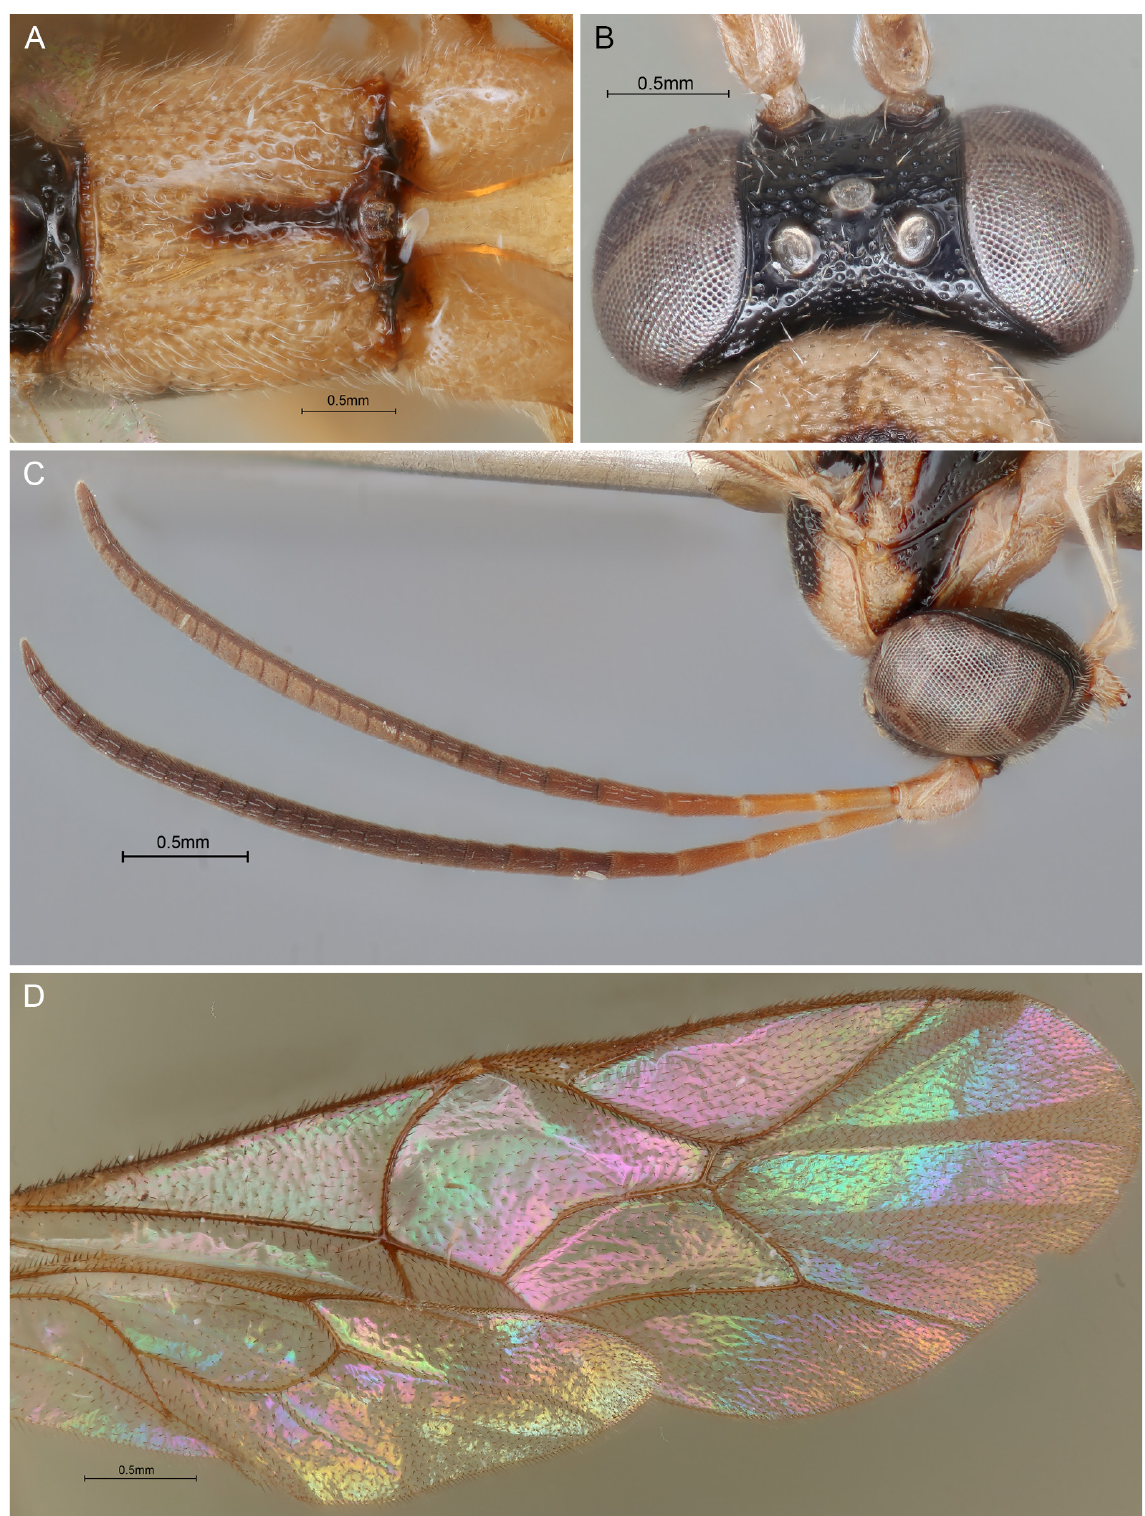
Fig. 16. Palpostilpnus ranui sp. nov., holotype, ♀ (NHMUK). A . Propodeum, dorsal view. B . Vertex. C . Antennae. D .